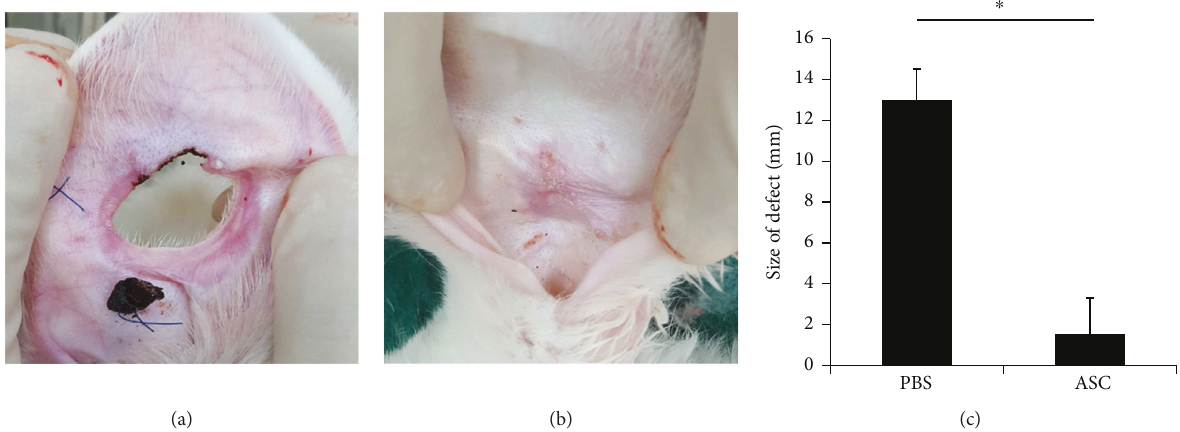
Figure 3: Gross fi ndings of auricular cartilage defect. (a) The defect of control group remained thin around the perforation. (b) In the ASC-treated ears, the defects were completely repaired by chondrocytes with smooth surface and similar color with the surrounding tissue. (c) The defect size was signi fi cantly smaller in the ASC group than in the PBS group. Data are expressed as the mean ± SEM. ∗ p = 0 008 . ASCs, adipose-derived stem cells; PBS, phosphate-bu ff ered